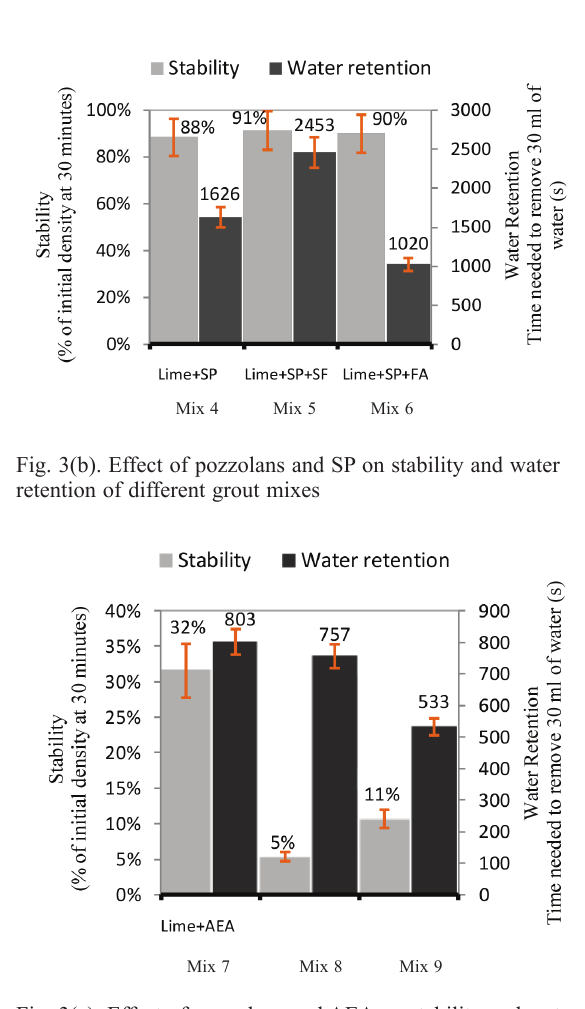
Fig. 3(a). Effect of pozzolans on stability and water retention of different grout mixes